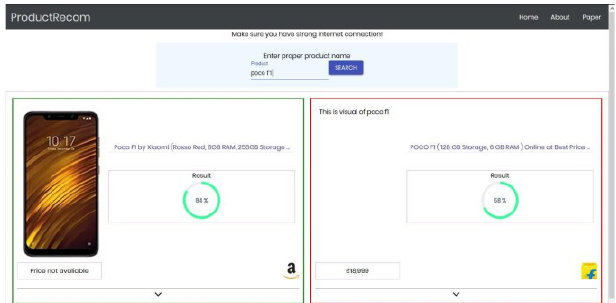
Fig. 4. Recommendation with different percentage